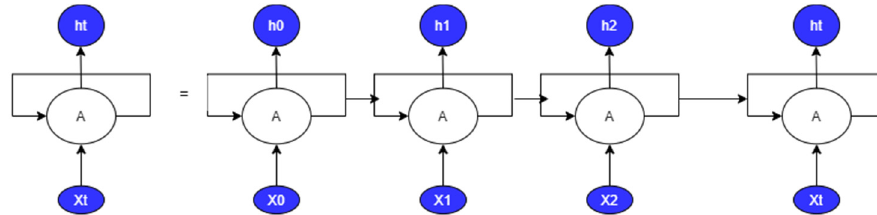
Figure 3. Folded RNN.